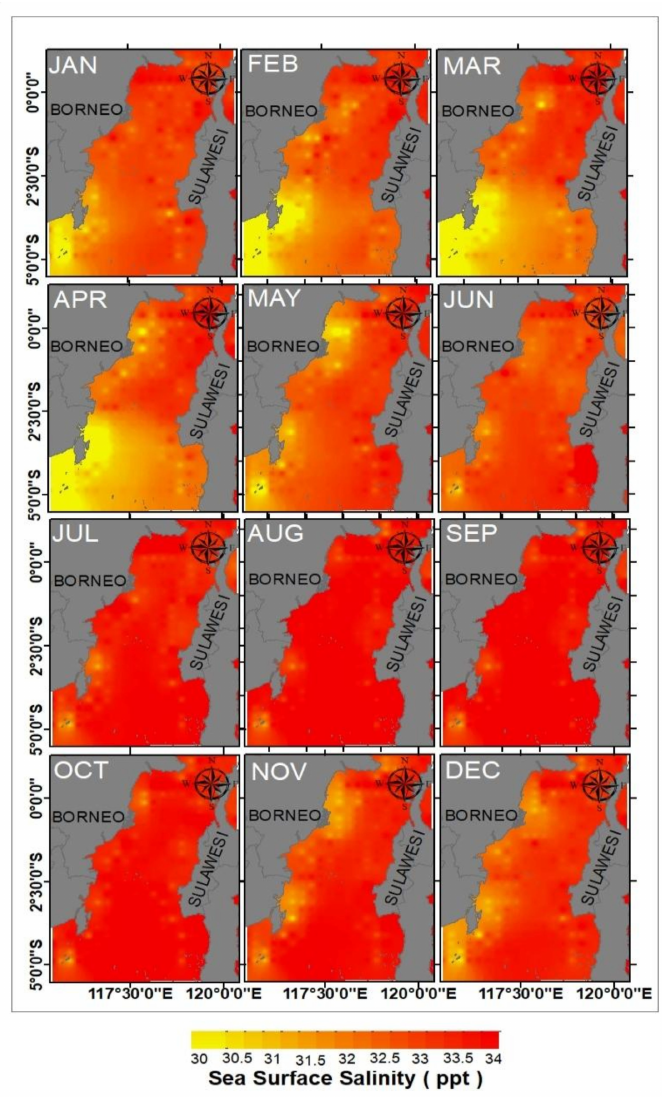
Figure 4. The Spatial Distribution Map of Average Salinity 2015–2020 in the Makassar